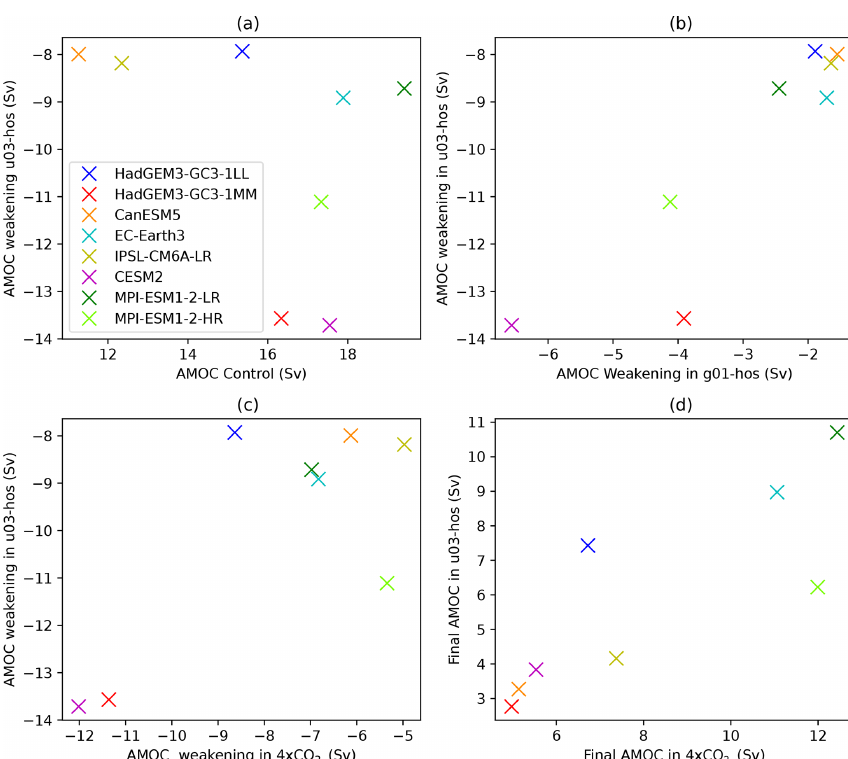
Figure 4. Relationships of AMOC weakening. (a) Comparison of AMOC anomaly (year 90–100 mean in u03-hos) with the AMOC strength in the control. (b) Comparison of AMOC anomalies in u03-hos (year 90–100) and in g01-hos (year 40–50). (c) Comparison of AMOC anomalies (year 90–100) in u03-hos and (year 140–150) in the 4 × CO 2 experiment. (d) As (c) but showing final AMOC strengths rather than anomalies. Colours indicate different